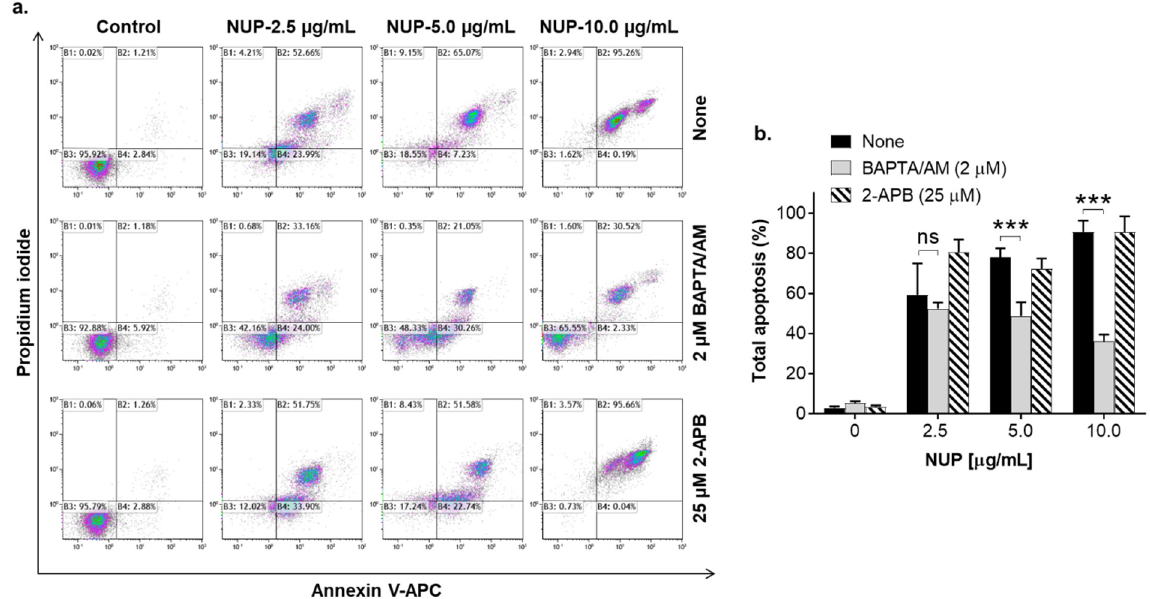
Figure 8. NUP-induced apoptosis is partially mediated by Ca 2+cyt rise. HL60 cells were preincubated with BAPTA/AM (1 µM) or 2-APB (25 µM) for 1 h, followed by treatment with the indicated NUP concentrations for 24 h. The extent of apoptosis was measured by the annexin-V/PI assay. ( a ) Typical flow cytometric data from a representative experiment; ( b ) Averaged percentages of apoptotic (early + late) cells. The data are means ± SD of 3 independent experiments performed in duplicate. ***, p < 0.001, significant differences between the indicated groups; ns, non-significant.